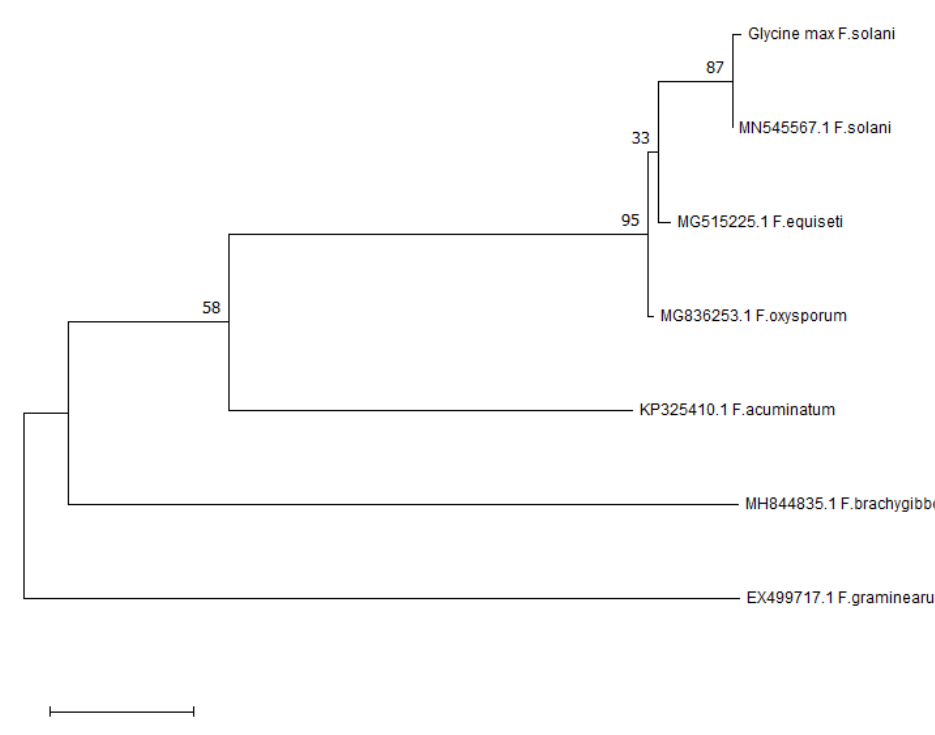
Figure 8. Phylogenetic tree based on the ITS-rRNA of the pathogenic fungus and other phyto- physical fungi. Note: The data comes from National Centre for Biotechnology Information Search database